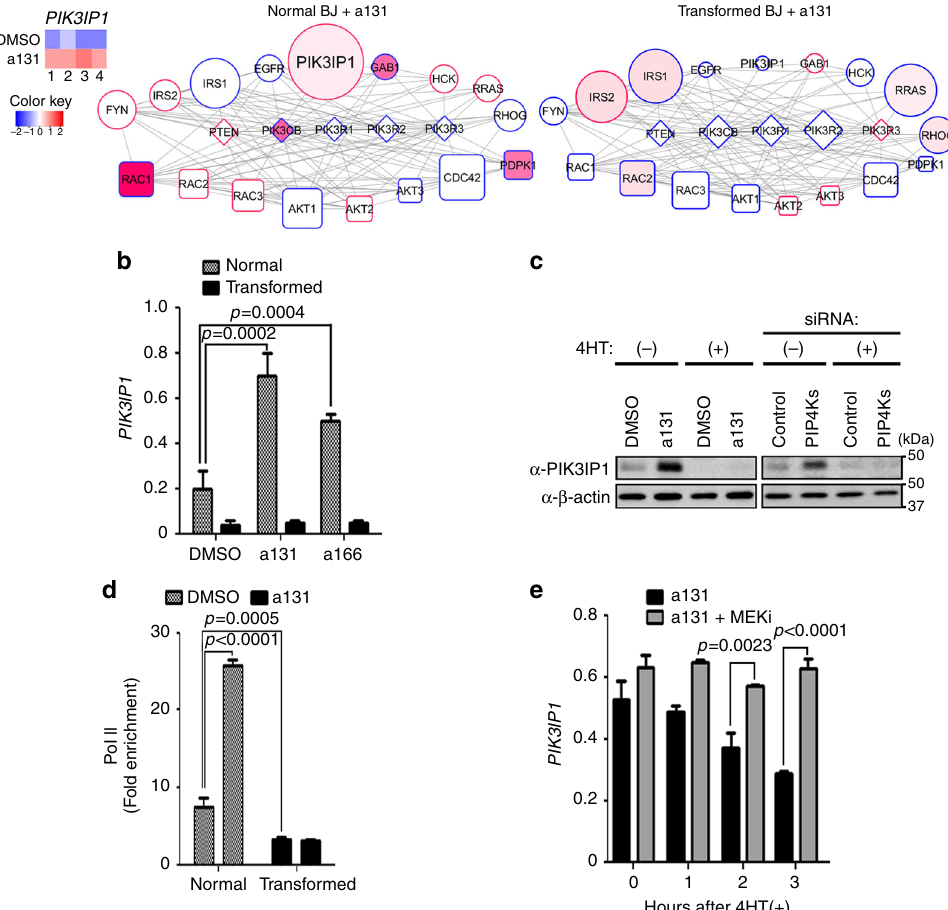
Fig. 4 Identi fi cation of positive cross-talk between Ras/Raf/MEK/ERK and PI3K/Akt/mTOR pathway via Ras ˧ PIK3IP1 ˧ PI3K signaling network. a The PI3K network analysis using gene expression of PI3K regulators in normal (middle) and transformed BJ cells (right) treated with a131 at 5 μ M for 24h. PI3K regulators, including PIK3IP1 , were identi fi ed to interact with PI3K with experimental support and high con fi dence from STRING. The per-sample expression pro fi les of PIK3IP1 are depicted in the heatmap (left). Color: negative log FDR (false discovery rate), coded from white to red in a scale from 0.15 to 5.37. Size: log ratio; Border: upregulation (red) or downregulation (blue); Shape: upstream (square), parallel (diamond) or downstream (circle). b , e qRT-PCR analysis of PIK3IP1 expression in BJ cell lines treated with a131 or a166 at 5 µ M for 24h. Mean values ± S.D. ( n = 3). c Immunoblot analysis of normal BJ cells treated with 4-OHT [4HT(+)] for 24h to activate H-RasV12-ER and subsequently with a131 (left) or transfected with indicated siRNAs for 48 h (right). Representative immunoblots shown ( n = 3). d ChIP analysis of normal BJ cells treated with a131 using antibodies against RNA polymerase II (Pol II) for the PIK3IP1 gene promoter ( n = 3). e Normal BJ cells treated with a131 were subsequently treated with MEK inhibitor U0126 (10 µ M) for additional 2h. Then, 4-OHT added to activate H-RasV12-ER for various time points. Where indicated, two-tailed unpaired t tests were performed to determine statistical signi fi cance NATURE COMMUNICATIONS | 8: 2200 | DOI: 10.1038/s41467-017-02287-5 |